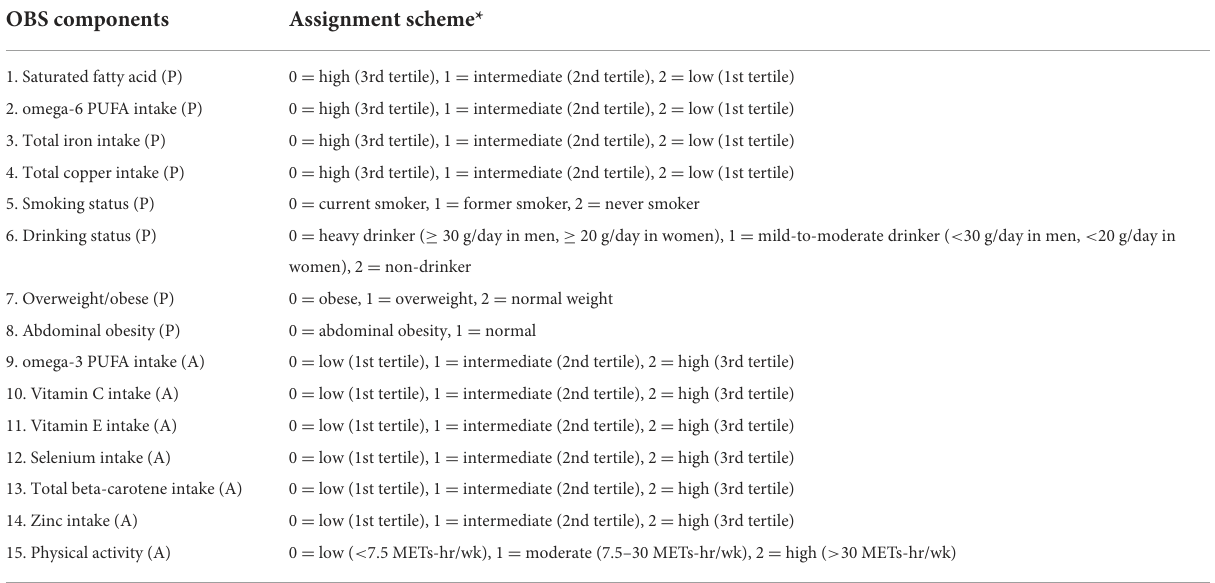
TABLE 1 Oxidative balance score assignment